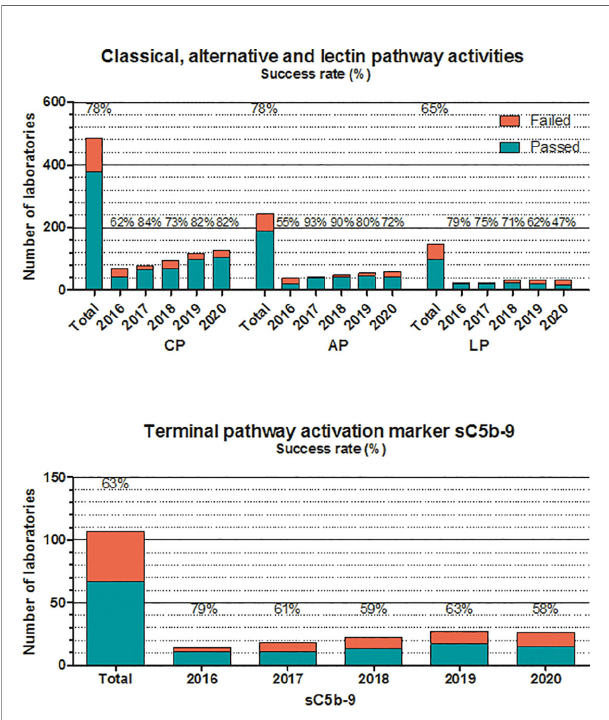
FIGURE 4 | Number of laboratories that “ failed ” or “ passed ” in the given year in the EQA program for classical, alternative, or lectin pathways, and terminal pathway activation marker sC5b-9. Success rate was calculated as frequency of laboratories with “ passed ” results among all of the participants. “ Total ” indicates the average success rate for the whole group in the past 5 years (2016 –